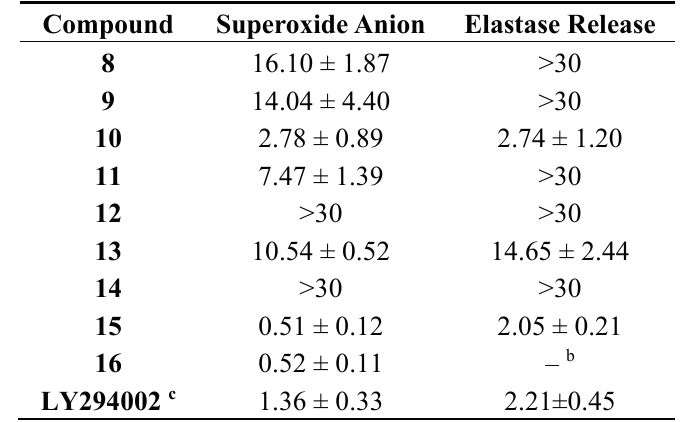
Table 1. Anti-inflammatory activities of benzo[ f ]indole-4,9-dione derivatives in formyl- L - methionyl- L -leucyl- L -phenylalanine (fMLF)-activated human neutrophils (IC 50 in μ M) a .